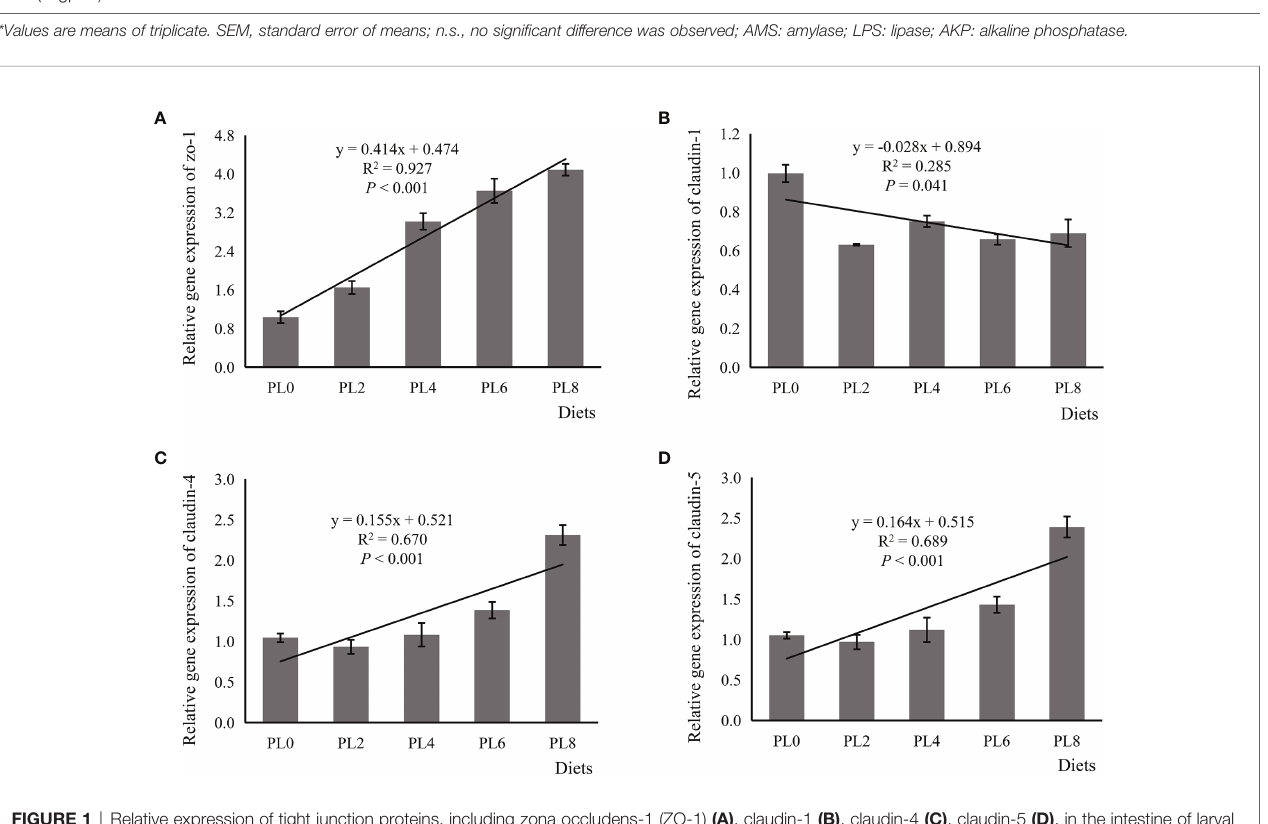
FIGURE 1 | Relative expression of tight junction proteins, including zona occludens-1 (ZO-1) (A) , claudin-1 (B) , claudin-4 (C) , claudin-5 (D) , in the intestine of larval largemouth bass fed diets with grade levels of phospholipids for 28 days. ZO-1: P linear < 0.001, R 2 linear = 0.927; P quadratic < 0.001, R 2 quadratic = 0.952; claudin-1: P linear = 0.041, R 2 linear = 0.285; P quadratic = 0.021, R 2 quadratic = 0.474; claudin-4: P linear < 0.001, R 2 linear = 0.670; P quadratic < 0.001, R 2 quadratic = 0.900; claudin-5: P linear < 0.001, R 2 linear = 0.689; P quadratic < 0.001, R 2 quadratic = 0.902. The “ x ” in the regression equation means the variation of dietary phospholipids content.